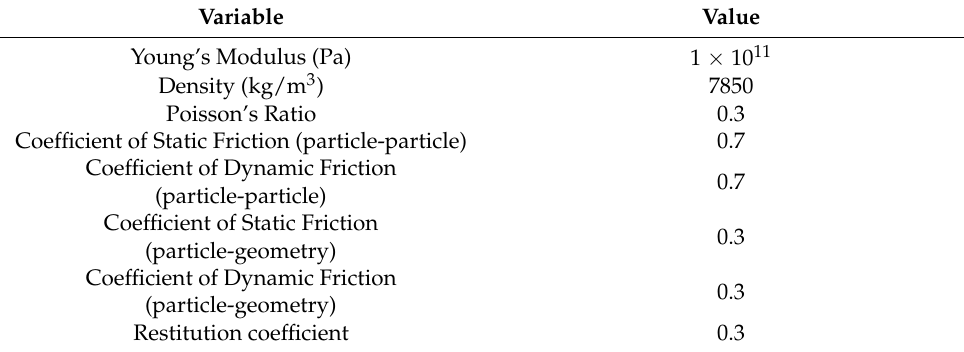
Table 2. Material and contact parameters used in the DEM simulations.